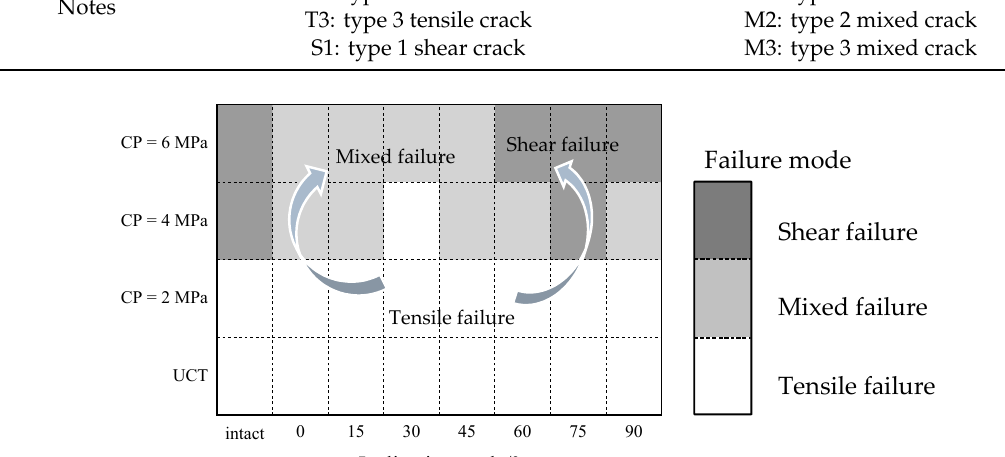
Figure 14. Failure mode of specimens under different confining pressure.